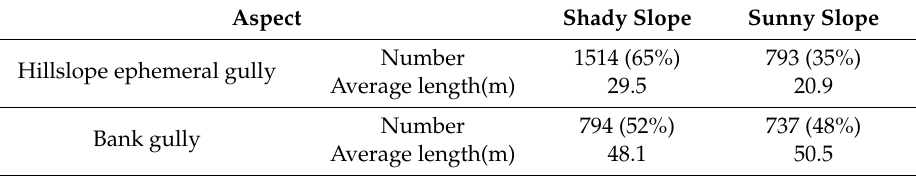
Figure 9. Distribution of hillslope ephemeral and bank gullies with topographic aspect. ( a ) hillslope ephemeral gullies; ( b ) bank gullies. Table 7. Number of gullies in sunny and shady slopes.